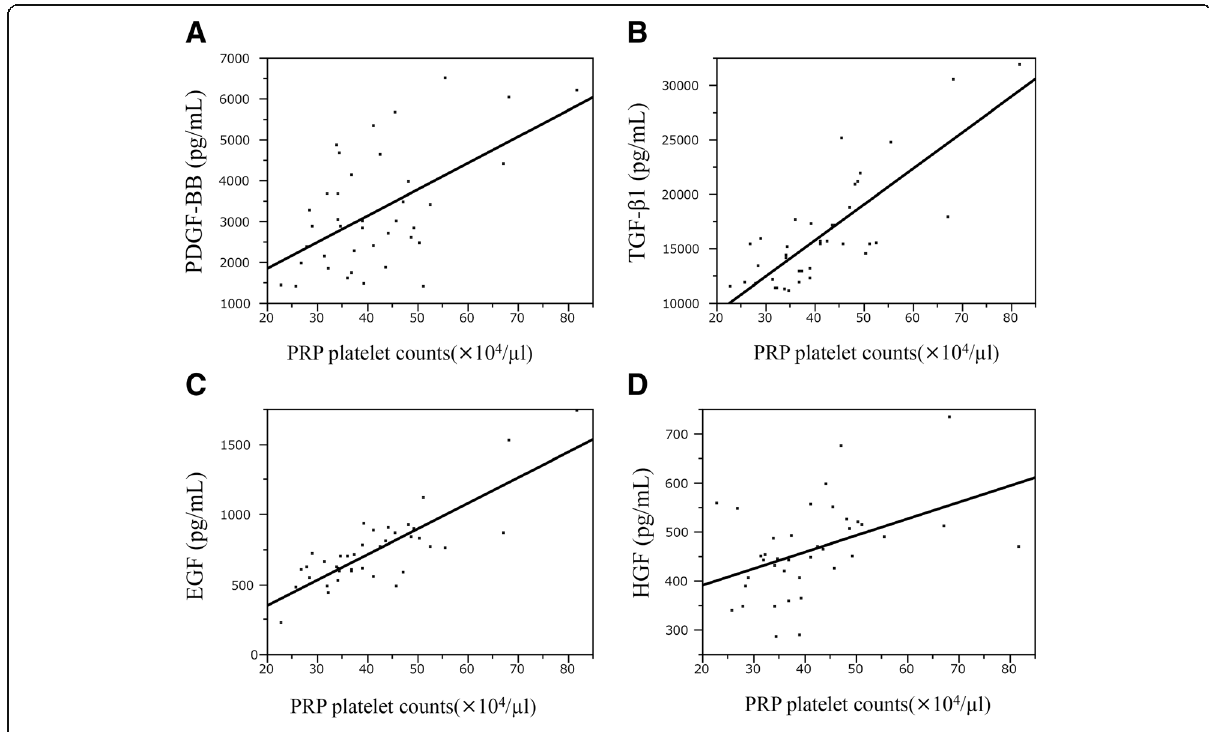
Fig. 2 ( a : PDGF-BB r=0. 39, p<0.05, b : TGF- β 1 r=0. 75, p<0.001, c : EGF r=0.71, p <0.001, d : HGF r=0.48, p